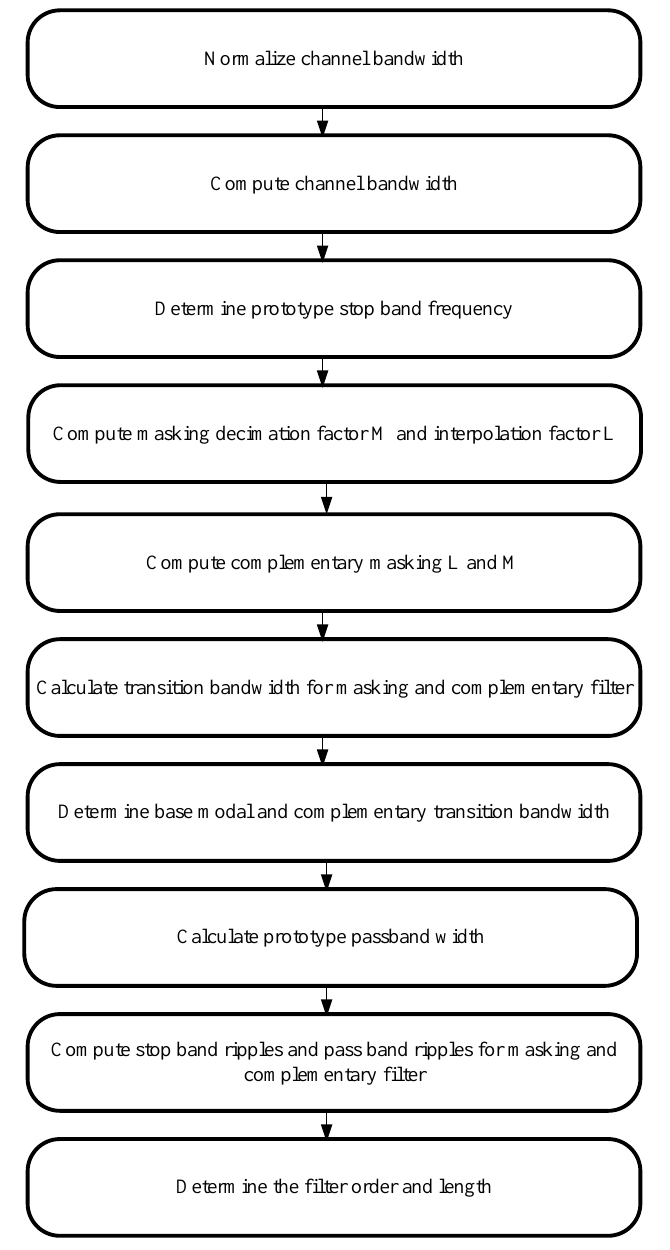
Figure 5. Step-by-step procedure for illustrating HFarrow